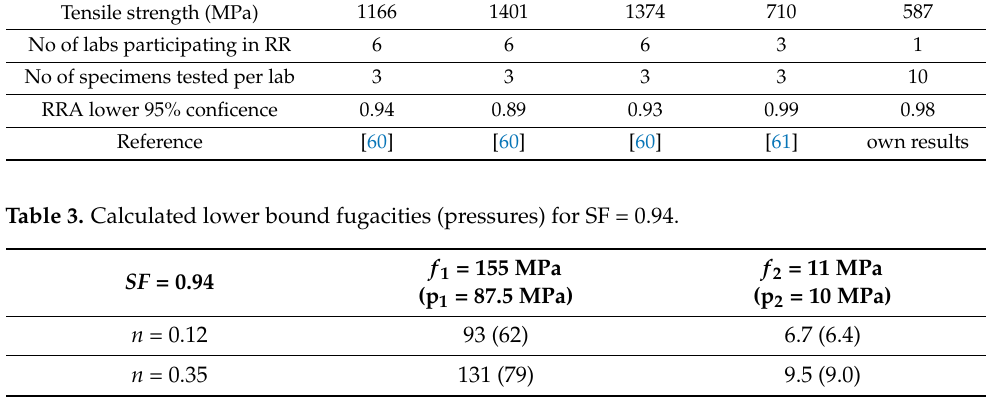
Figure 7. Severity factor (SF) quantifying the effect of hydrogen fugacity on hydrogen embrittlement indices assuming an f n law with f 1 = 155 MPa and f 2 = 11 MPa as use cases. For example, for f 1 = 155 MPa and | n | = 0.12, the severity factor of SF = 0.94 indicates that a fugacity of approximately 93 MPa is less severe by a factor of 0.94 compared to a fugacity of 155 MPa.